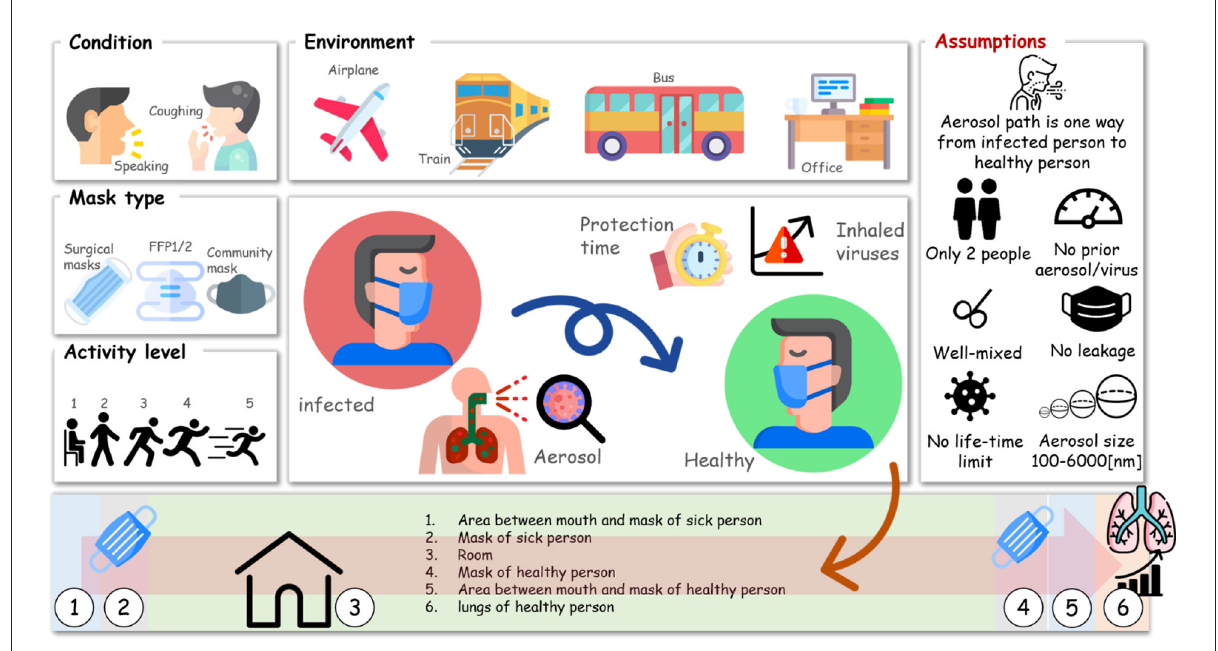
FIGURE2 The overall structure of the modeling system, including breathing condition, mask type, environment, activity level, and modeling assumptions, is depicted here (the icons are from https://www.flaticon.com/).